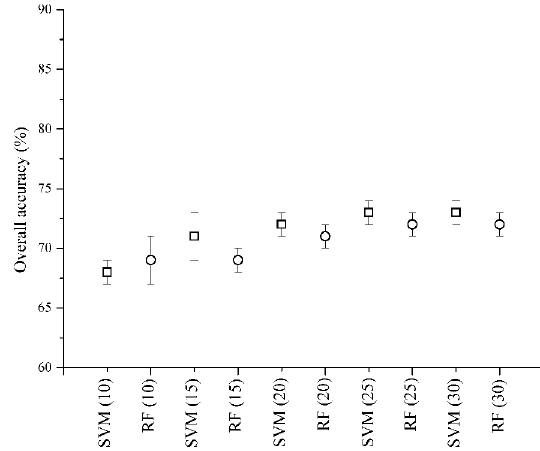
Figure 2. Overall accuracies of RF and the SVM classifiers. Original bands and different number of random training pixels (N = 10; 15; 20; 25 or 30) were used from each vegetation class (mean ± SD).